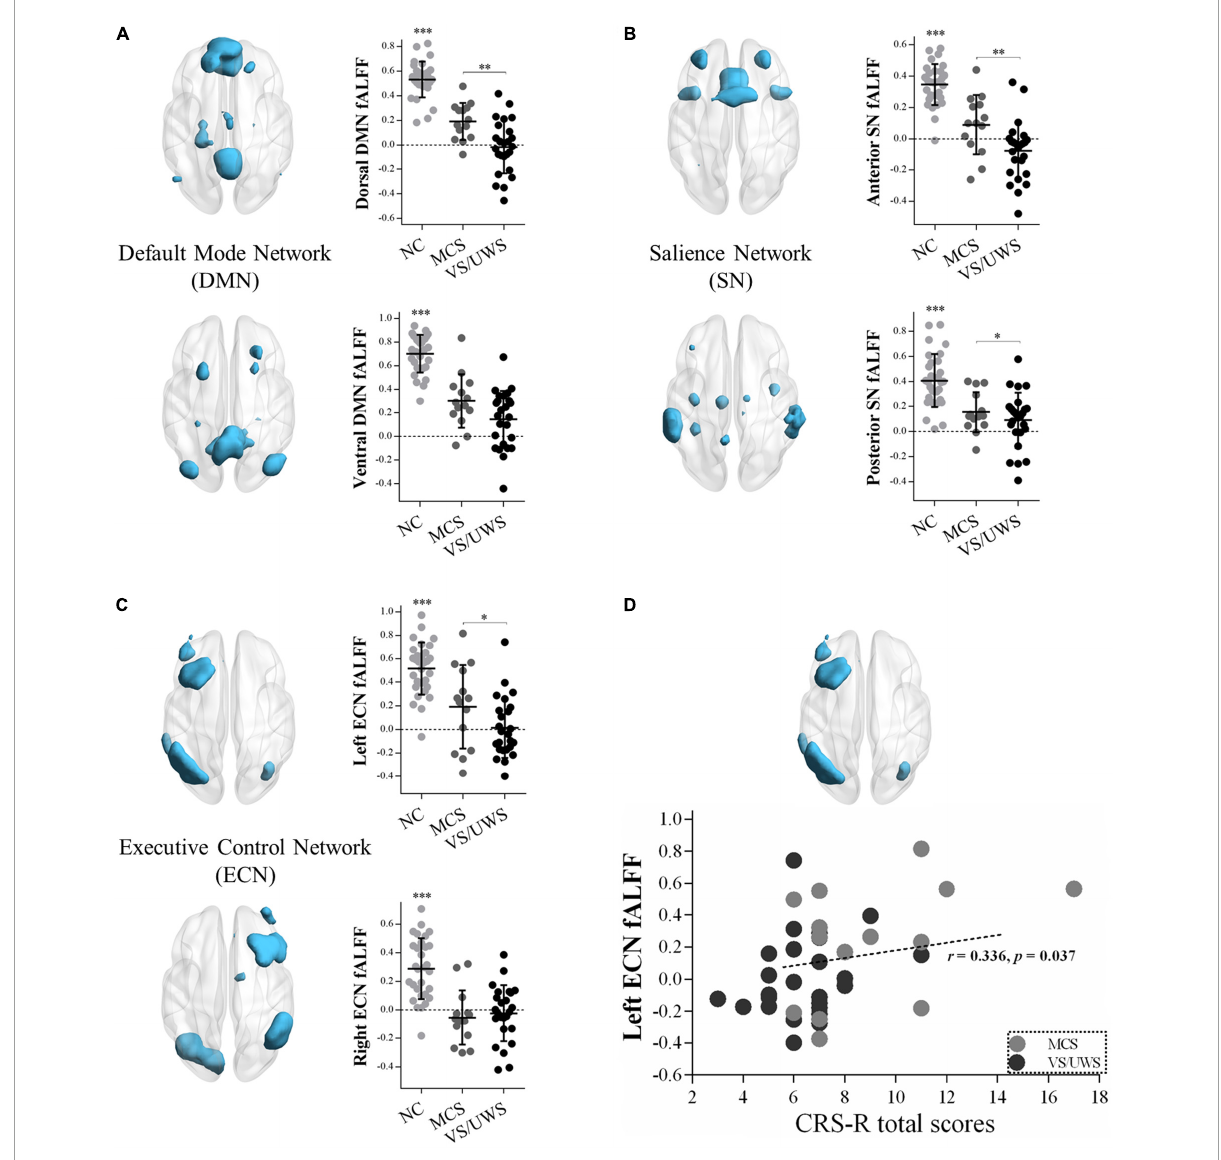
FIGURE2 fALFF differences within the triple-network model and correlations with CRS-R total scores in MCS and VS/UWS patient groups and NC group. Reduced fALFF within the masks of dorsal/ventral DMN (A) , anterior/posterior SN (B) , and left/right ECN (C) were shown. As the clinical manifestations of DOC deteriorated from MCS to VS/UWS, fALFF within dorsal DMN ( A top), anterior/posterior SN ( B top/bottom), and left ECN ( C top) became significantly reduced. Correlations between fALFF of the left ECN and CRS-R total scores were found across all DOC patients (D) (fALFF, fractional amplitude of low-frequency fluctuation; CRS-R, Coma Recovery Scale-Revised; DOC, disorders of consciousness; NC, healthy control individuals; MCS, minimally conscious state; VS/UWS, vegetative-state/unresponsive wakefulness syndrome; ∗ p < 0.05; ∗∗ p < 0.01; ∗∗∗ p < 0.001; error bars represent the standard error of